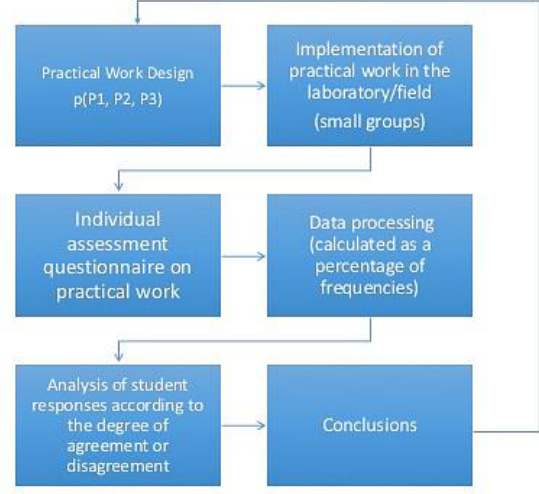
Figure 3. Flowchart about research